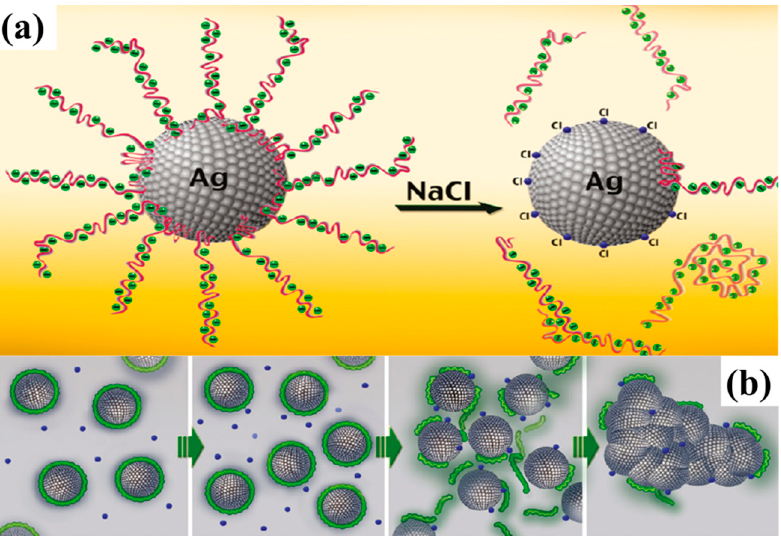
Figure 1. ( a ) schematic illustration of the Ag NPs before (left) and after (right) the addition of NaCl, and ( b ) schematic illustration of the protective agents detachment, which leads to the Ag NPs sintering (the green lines represent the polymeric stabilizer; the blue spheres represent the sintering agent). Reproduced with permission from [42]; Copyright 2011 American Chemical Society.